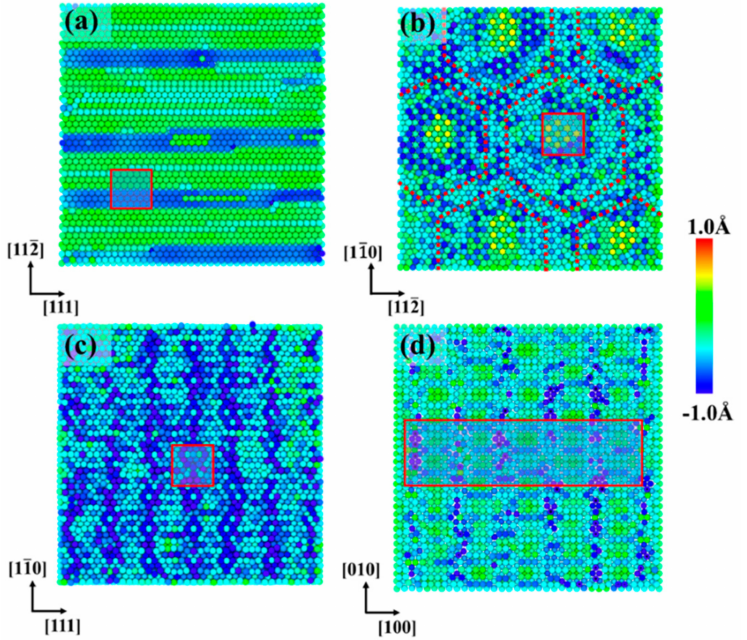
Figure 5. Displacement distribution of graphene/Fe ( a ) (110), ( b ) (111), ( c ) (112), and ( d ) (001) interface, calculated from MD simulations using EAM potential of